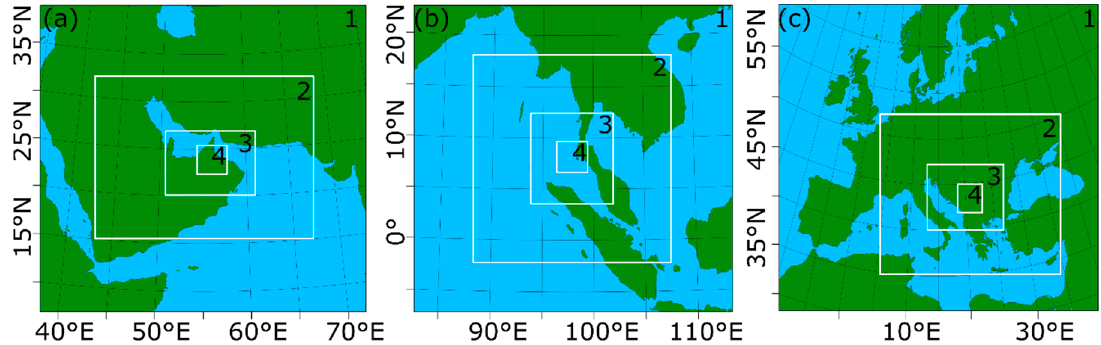
Figure 4. Weather research and forecasting (WRF) model domains with the focus on: ( a ) UAE; ( b ) Thailand; and ( c ) Serbia.